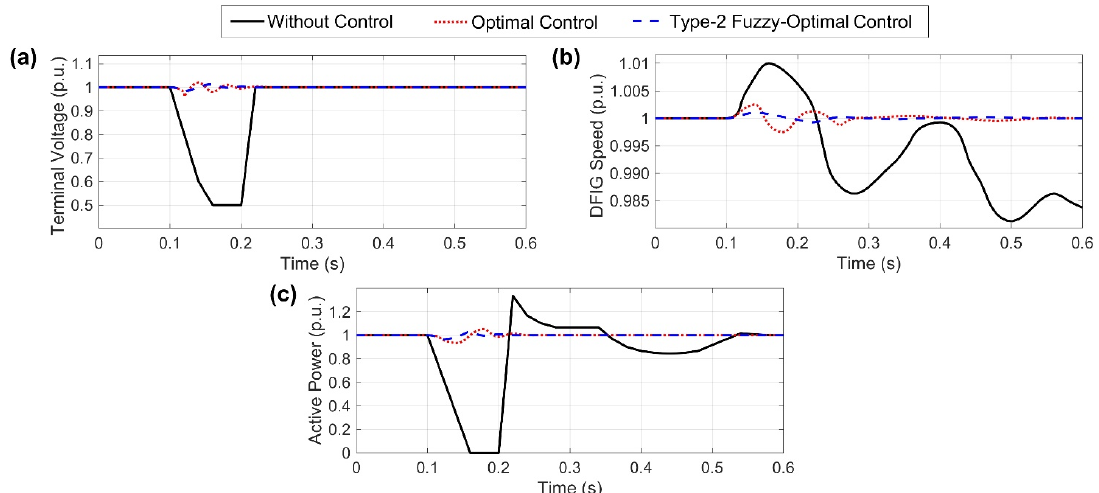
Figure 6. ( a ) Terminal voltage in three-phase-to-ground fault, ( b ) DFIG speed in three-phase-to- ground fault, and ( c ) active power in three-phase-to-ground fault.